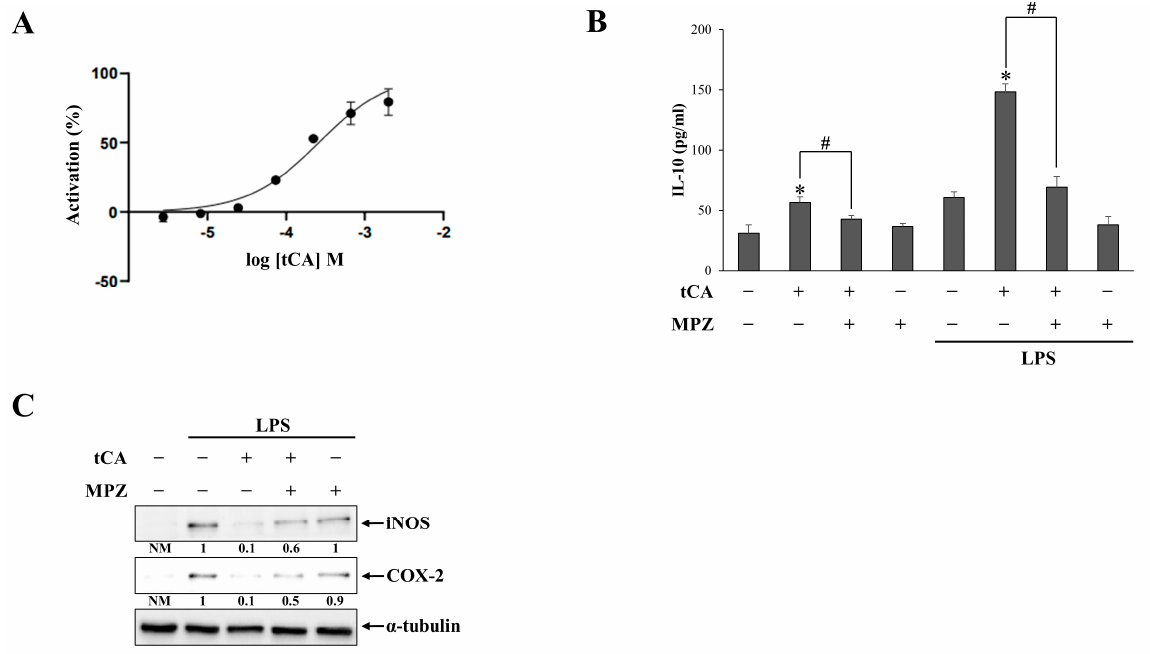
Figure 4. tCA is a GPR109A agonist. ( A ) Agonistic activity of tCA on GPR109A was measured using a calcium mobilization assay. Nicotinic acid (10 µ M) was used as a reference agent whose activity of GPR109A is set as 100%, and tCA activity is presented as the percentage activation. ( B ) RAW264.7 cells were 1 h-pretreated with MPZ (100 µ M) and tCA (5 mM) and, then, were challenged with lipopolysaccharide (LPS) for 24 h. The cell supernatants were subjected to ELISA, using a kit to determine the levels of IL-10. ( C ) RAW264.7 cells, pretreated with MPZ (100 µ M) and tCA (5 mM) analyzed using Western blotting. α -Tubulin was used as a loading control. NM: not measurable. followed by Tukey’s HSD test, * p < 0.05, vs. Control. # p < 0.05.